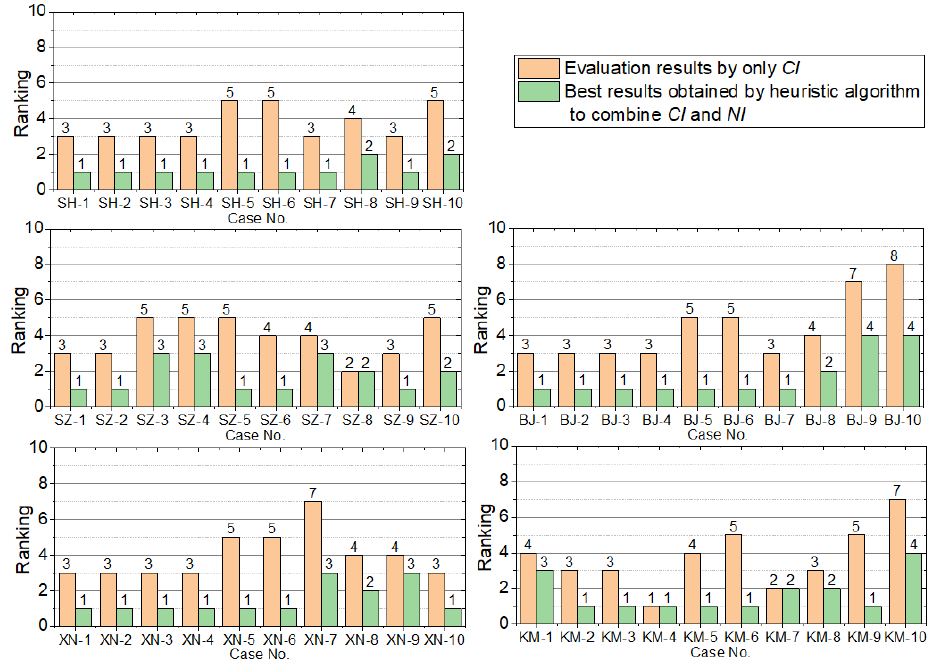
Figure 6. Specific rankings of 50 cases before and after the optimization.